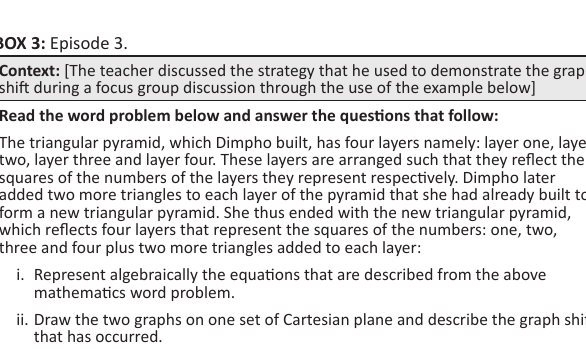
FIGURE 1: Shifting of the